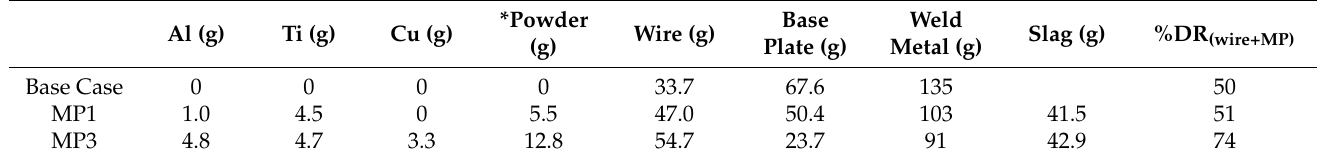
Table 5. Post weld masses and metal powder mass added to weld metal.